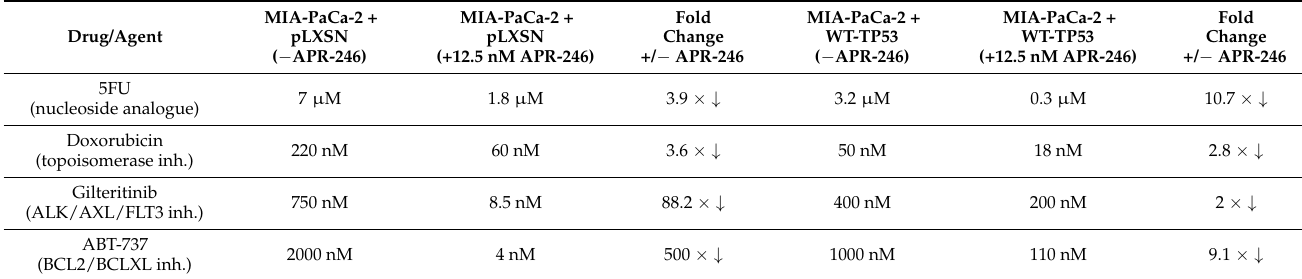
Table 1. Effects of WT-TP53 on the sensitivity of MIA-PaCa-2 PDAC cells to APR-246 1 .